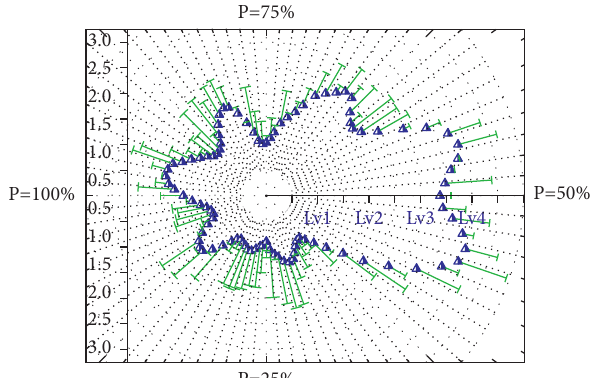
Figure 4: The evolutionary process of optimal individual adap- tation values.